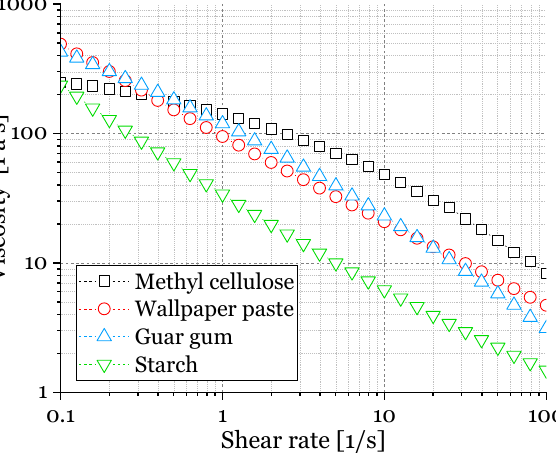
Figure 3. Viscosity vs. shear rate of ceramic dispersions with 30 vol.% solid load for coating of Polyurethane (PU) templates.